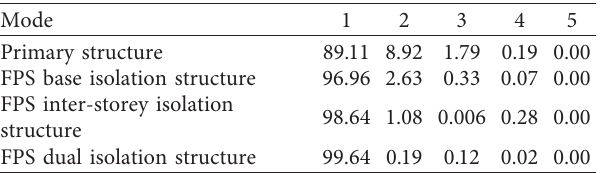
Table 3: X -direction mode participation mass coefficient of structure/( %